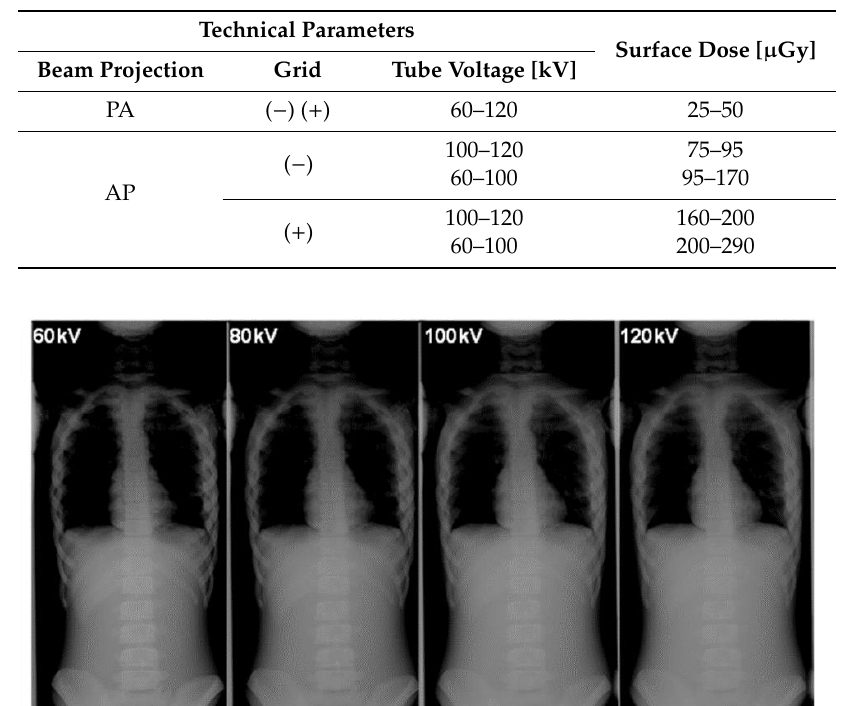
Parameters for full-spinal radiographs and measured breast surface doses (BSDs).